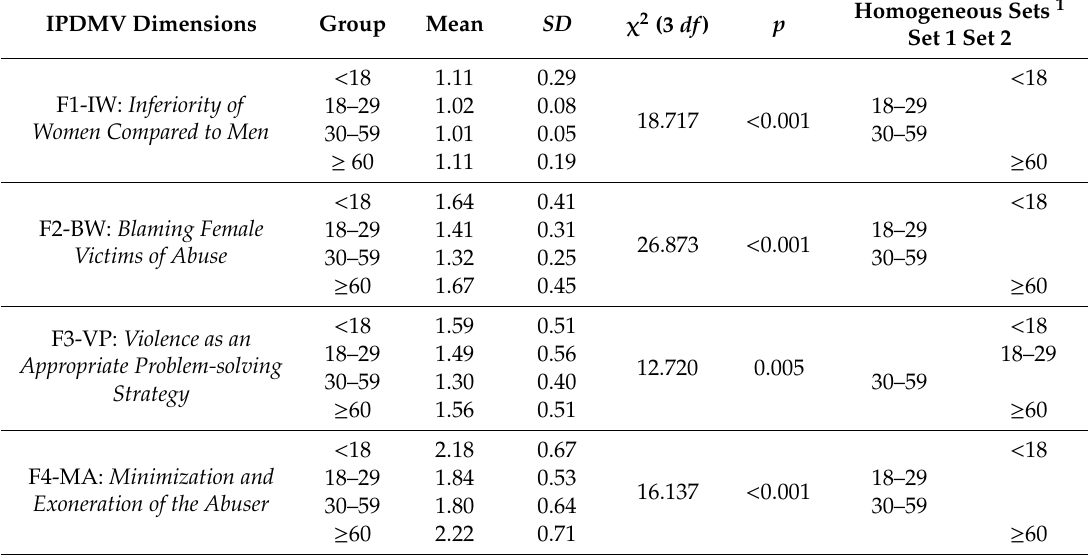
Table 2. IPDMV: Mean differences among age groups.